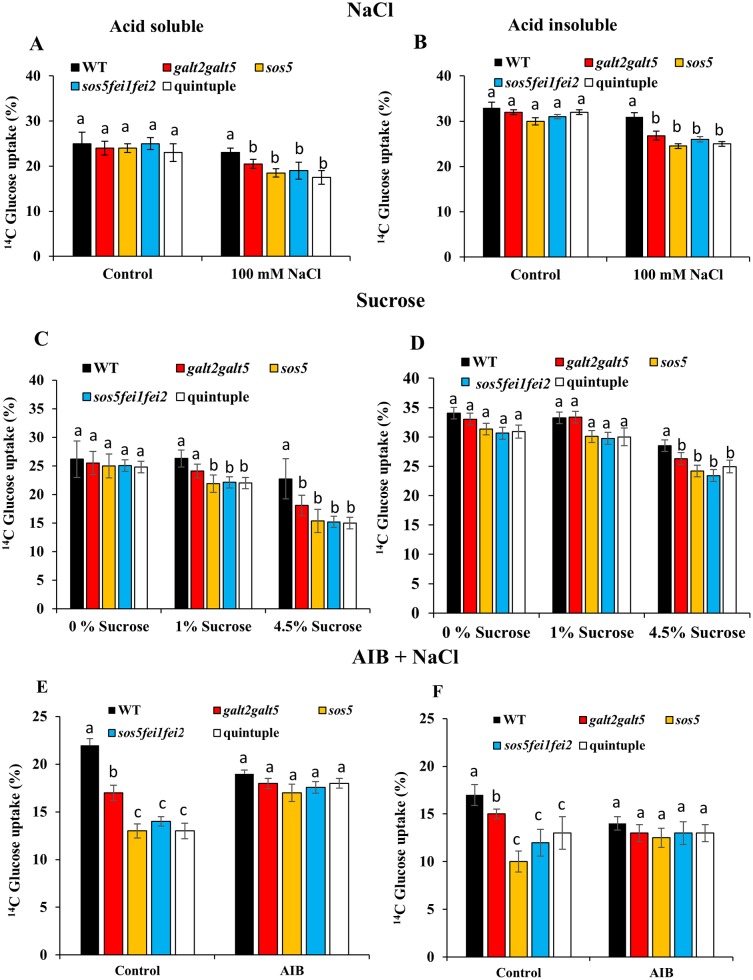
Quintuple mutants display a cellulose deficiency in response to salt.(A) and (B) Incorporation of [14C]Glc into acid-soluble and acid-insoluble fractions from excised root tips from WT and mutant seedlings in response to 100 mM NaCl, (C) and (D) in response to 4.5% sucrose and (E) and (F) in response to AIB. Seedlings were grown on 0% sucrose for 5 d and then transferred to the three different treatment conditions for 7d. (A), (C), and (E) indicate incorporation of [14C]Glc into the acid soluble fraction, and (B), (D), and (F) indicate incorporation of [14C]Glc into the acid insoluble fraction. Values are means ± SD from two biological replicates, and the experiments were repeated at least two times with similar results. Different letters indicate statistically significant differences (P < 0.05) between means.